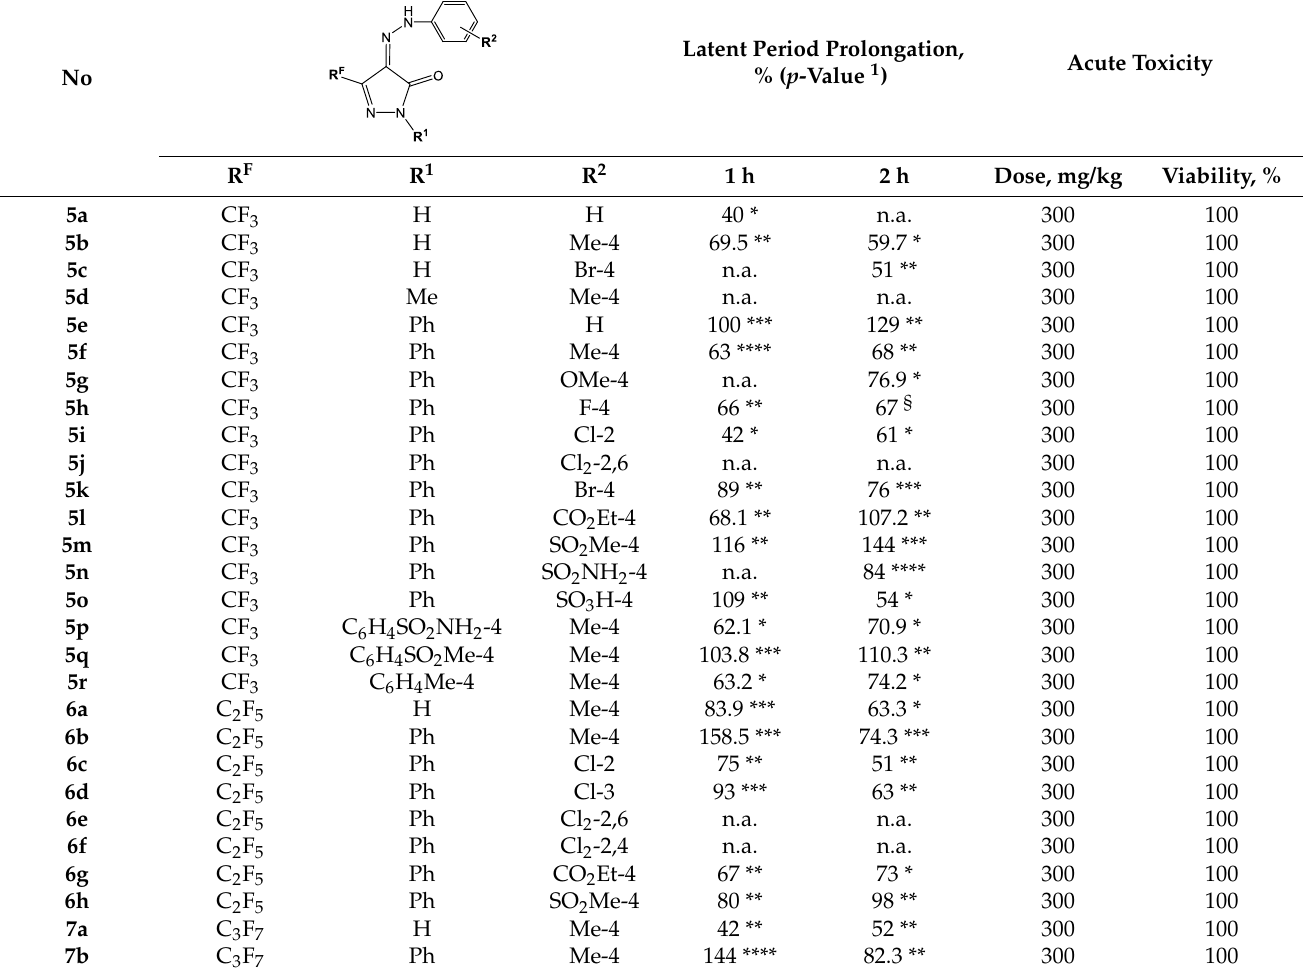
Table 8. Analgesic activity in hot plate test (dose 15 mg/kg, rats, ip ) and acute toxicity (three mice, ip ) of 4-AHPs 5–9 .